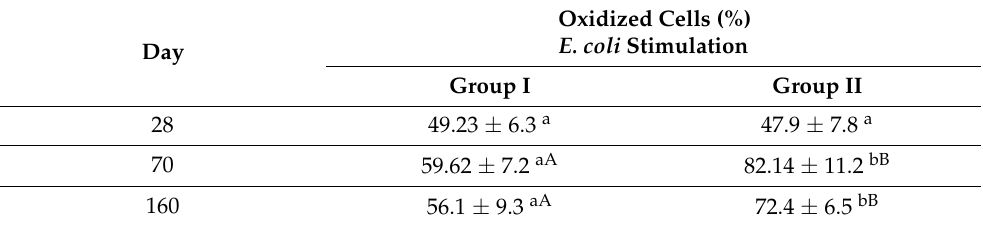
Table 4. Granulocyte and monocyte oxidative burst under E. coli stimulation of pigs from groups I and II. Values are expressed as mean and standard deviation ( α +/ − SD). Oxidized Cells (%) E. coli Stimulation Day Group I Group II